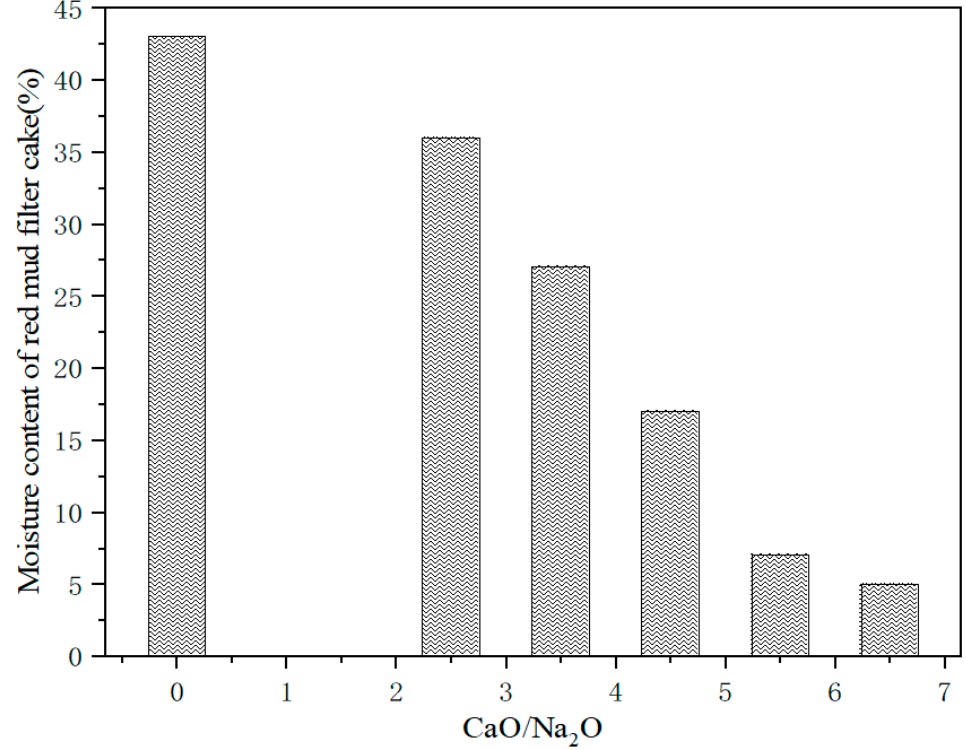
Figure 17. Effect of CaO addition on the moisture content of red-mud filter cake.